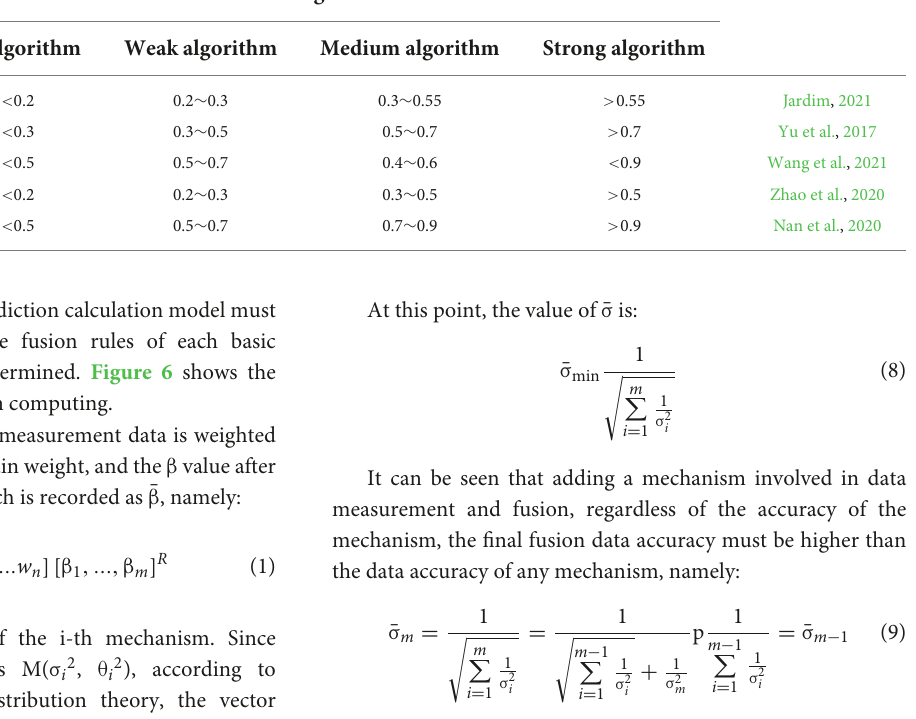
TABLE 1 Some common criteria of